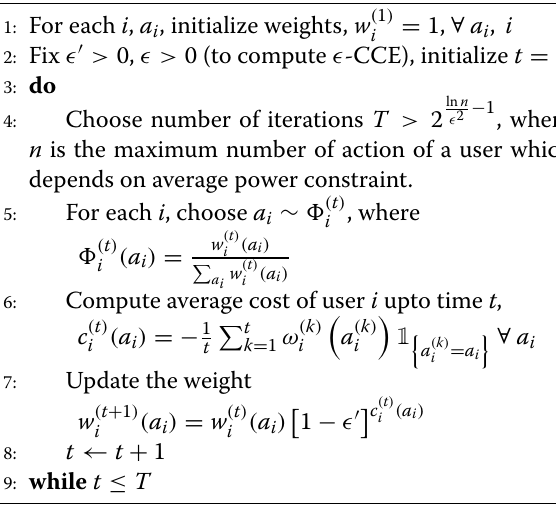
Algorithm 1 Multiplicative Weights